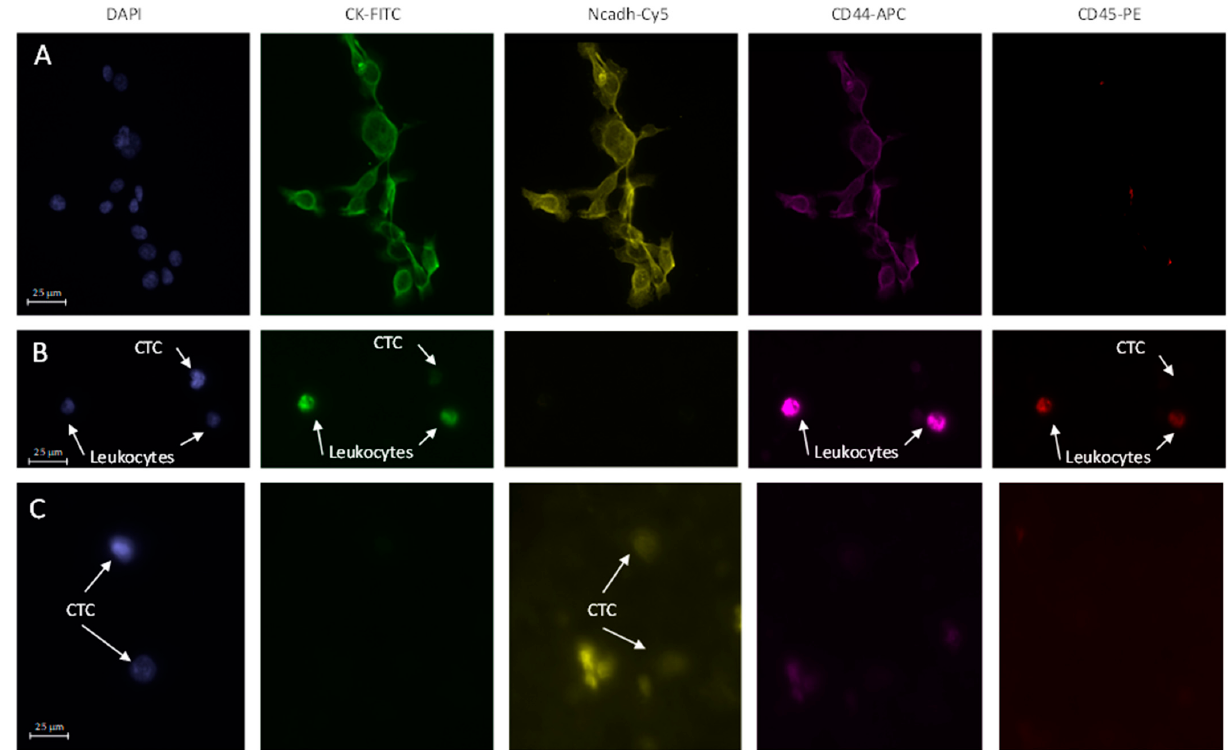
Figure 1. Immunofluorescence stainings (X20): ( A ) SQ20B-CD44+ cancer stem cells expressing cytokeratin, N-cadherin and CD44; ( B ) Representative CTC observed in patient #12, expressing cytokeratin at baseline; ( C ) Representative CTCs observed in patient #1, expressing N-Cadherin at